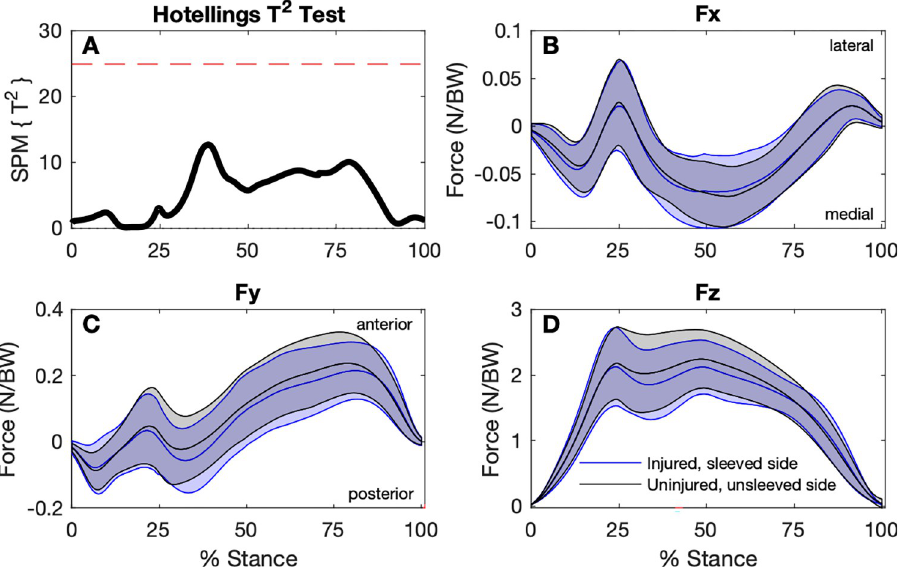
Fig 4. Comparison of ground reaction forces during the stance phase of the step-down hop for the ACL-injured sleeved sides to the uninjured unsleeved sides (n = 30). A: SPM Hotellings T 2 test trajectory, dashed red line indicates adjusted significance criterion; B to D: x (lateral/medial), y (anterior/posterior), and z (vertical) component curves (mean and ± 1 standard deviation bands), respectively.